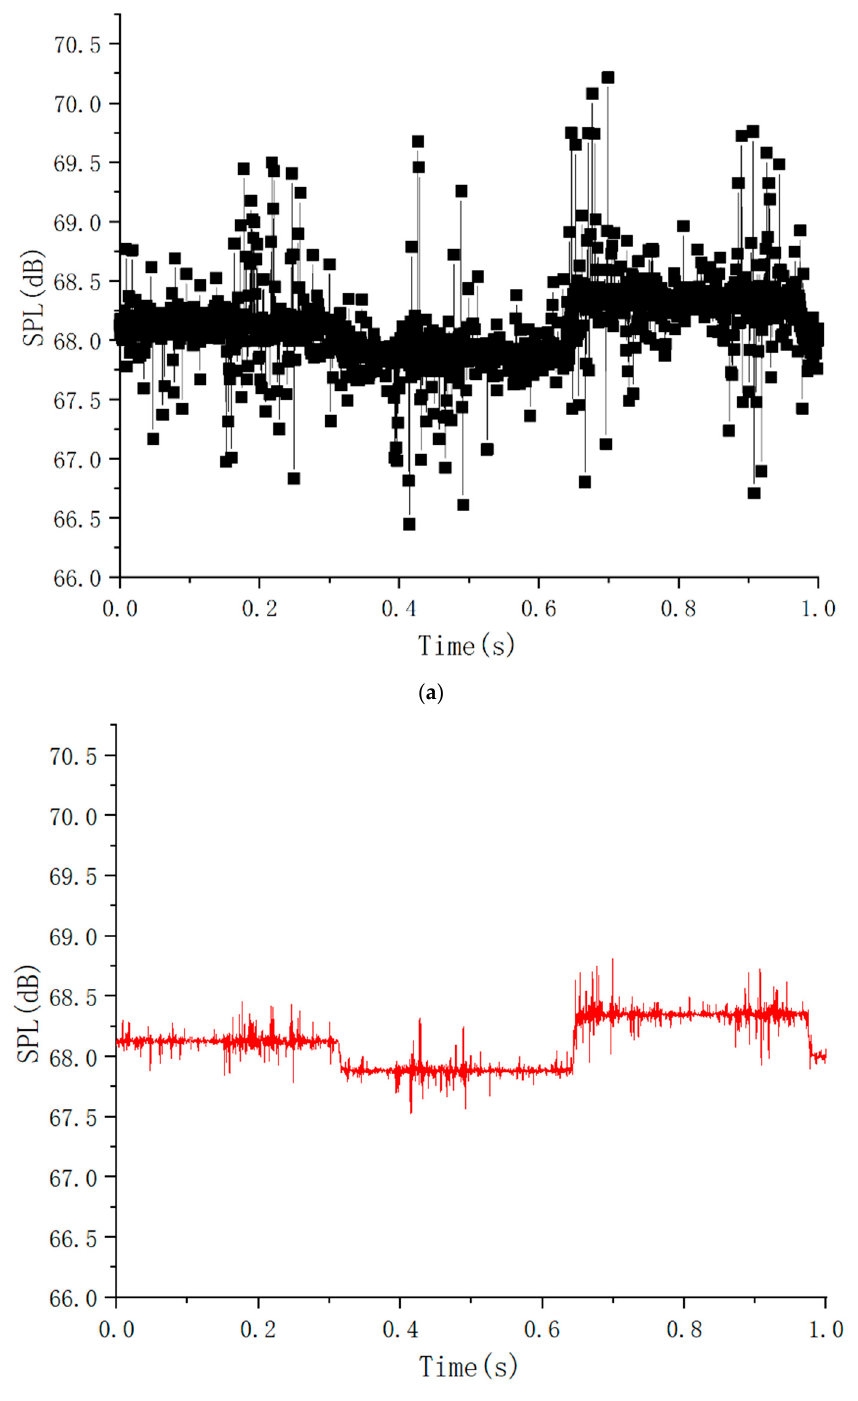
Figure 6. FFT fitting of sound pressure level: ( a ) original time domain diagram of sound pressure level; ( b ) sound pressure level after smooth application.